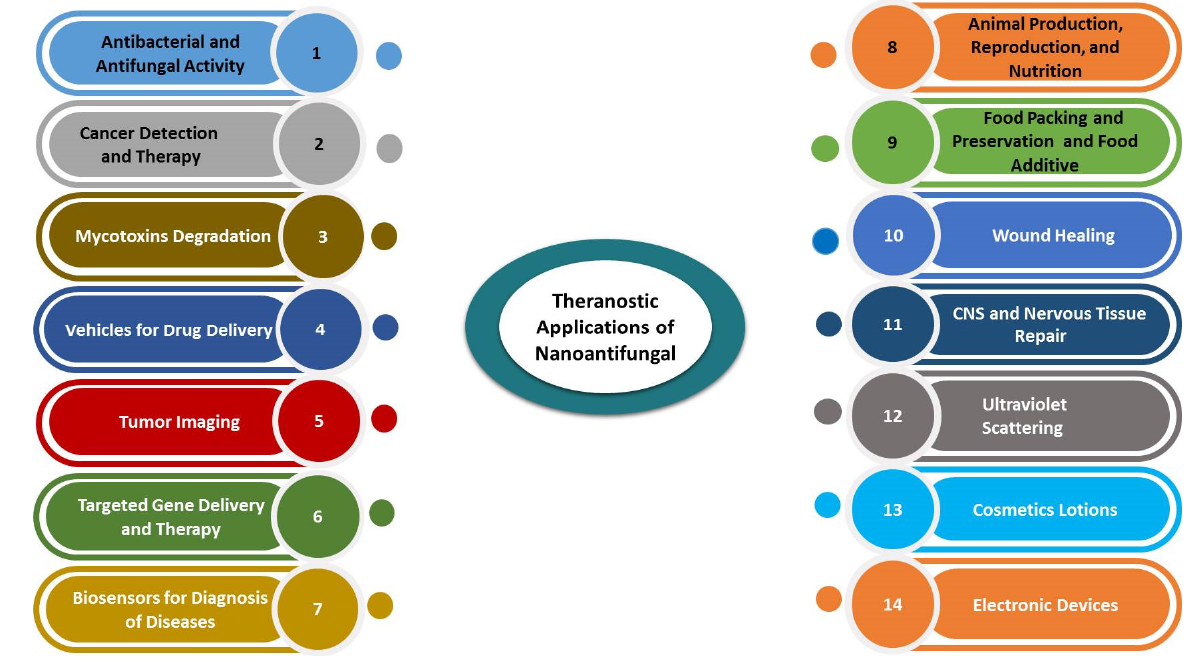
Figure 3. Theragnostic applications of nanoantifungals in animal science.